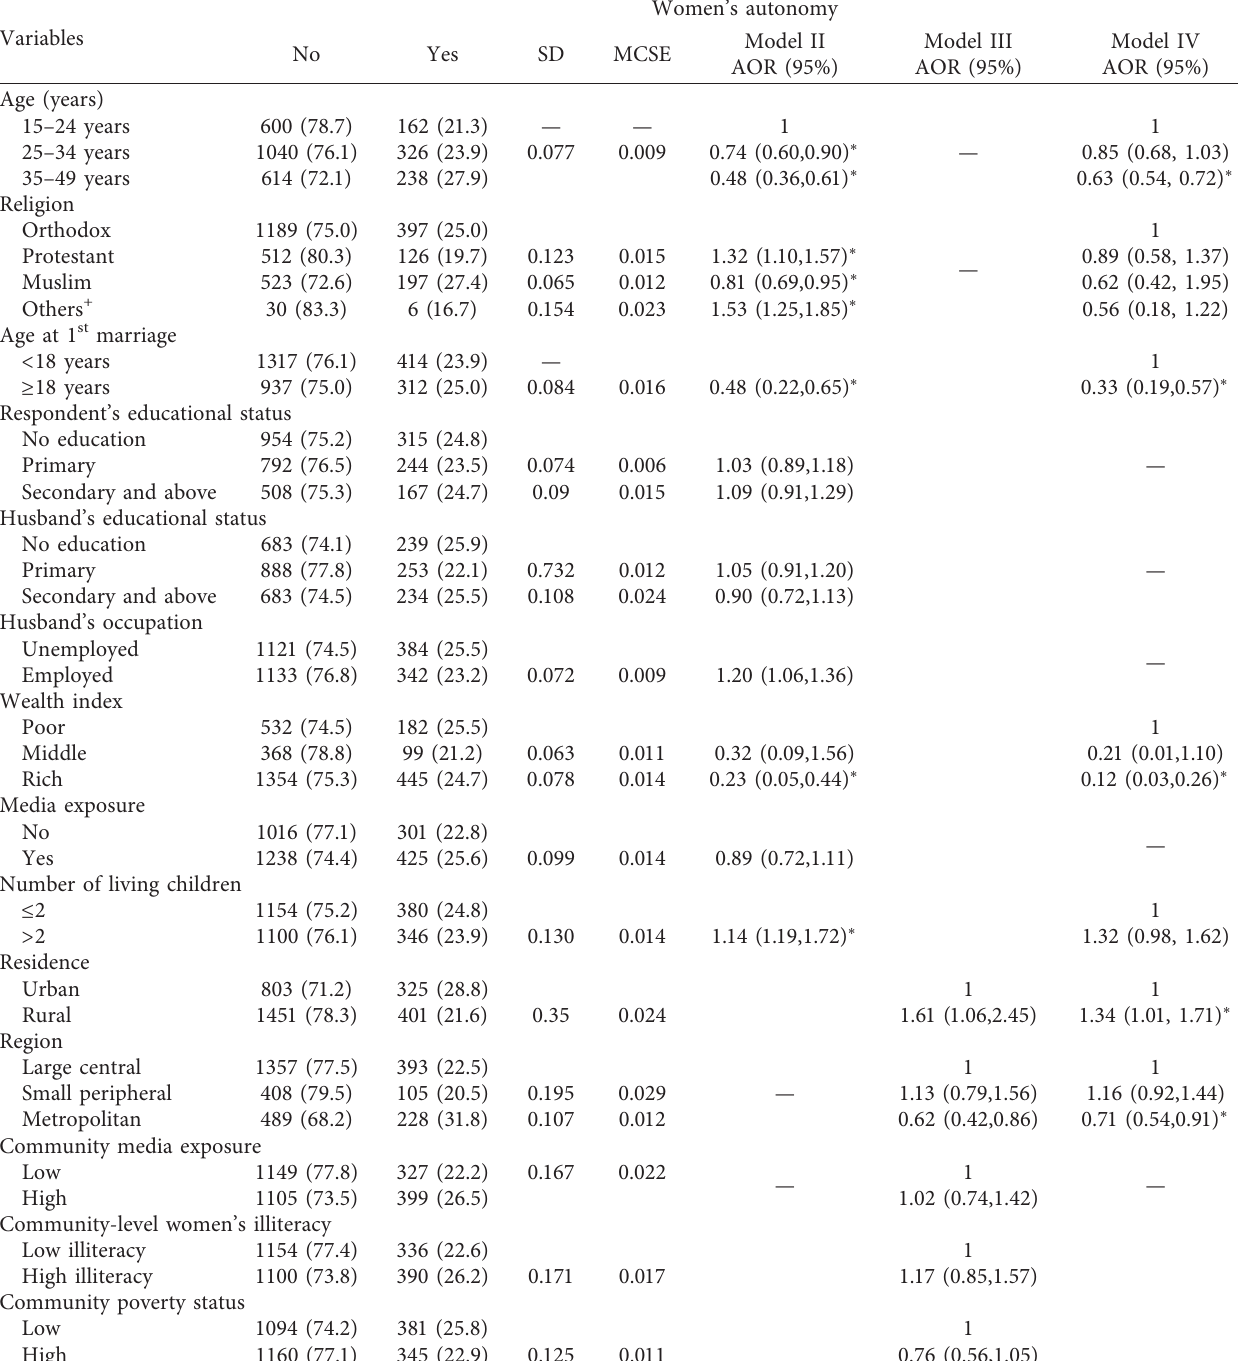
Table 4: Bayesian multilevel multivariable logistic regression of the individual- and community-related variables associated with women’s nonautonomy on contraceptive utilization, Ethiopia,